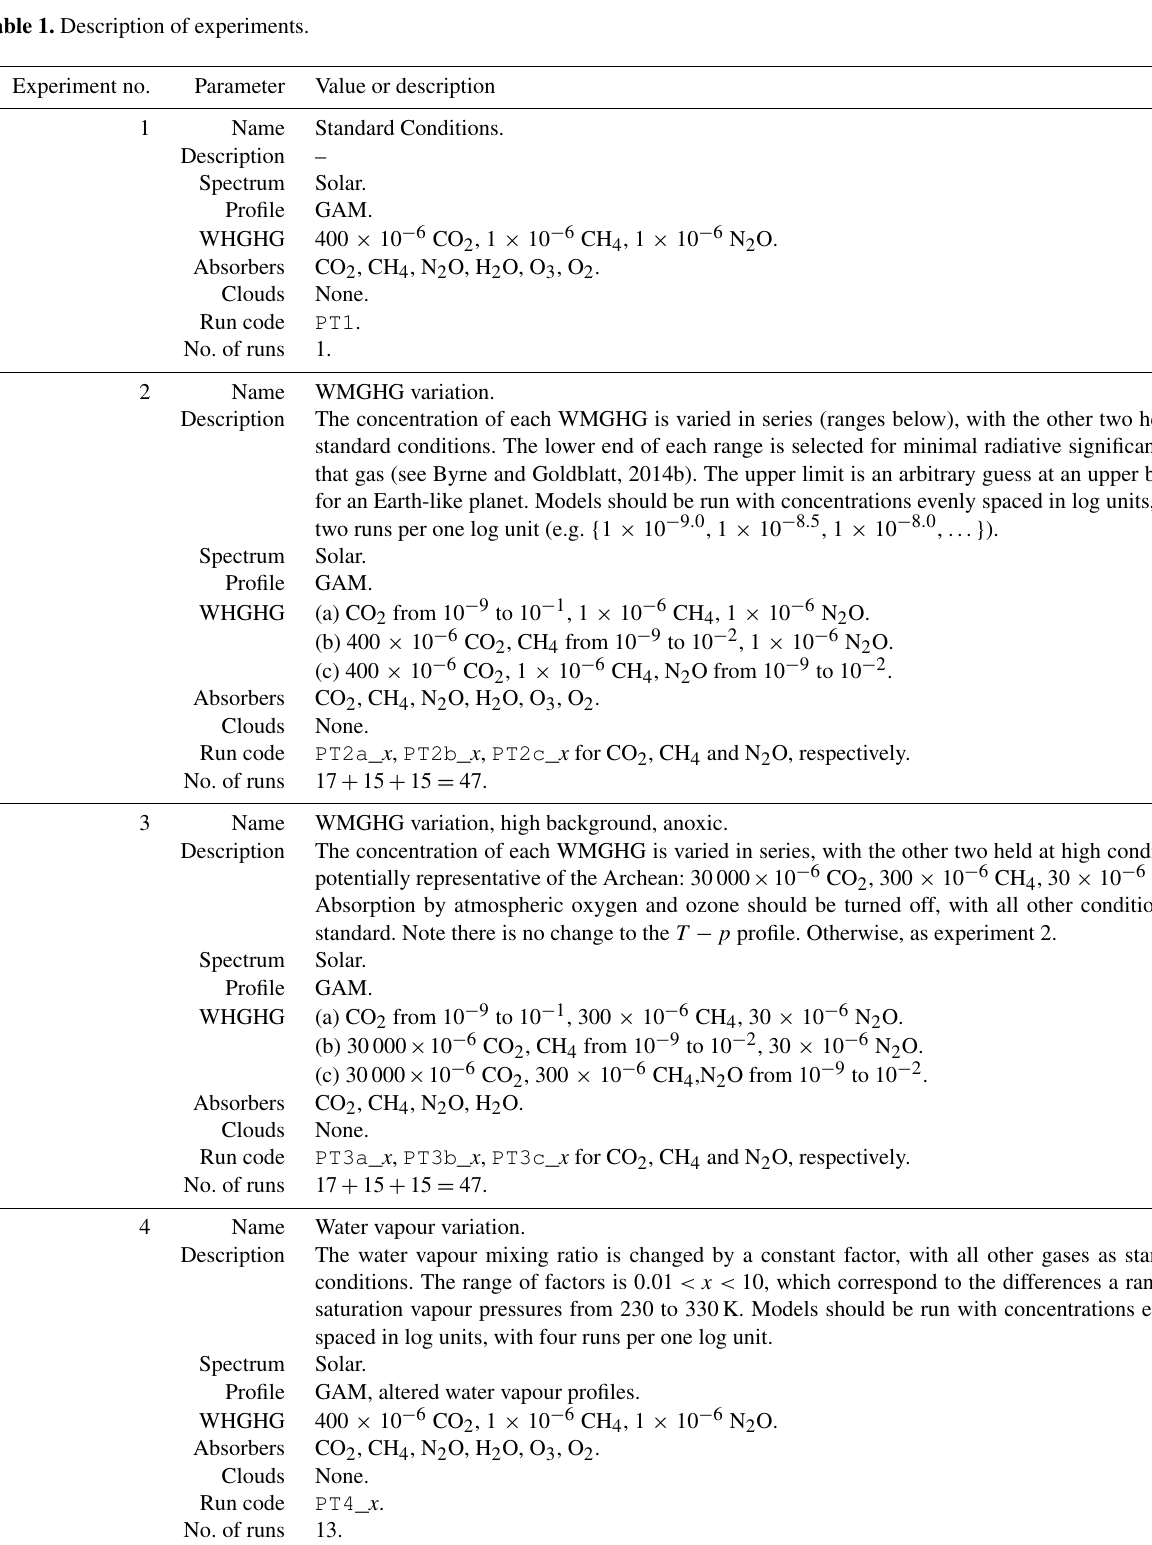
Table 1. Description of experiments. Experiment